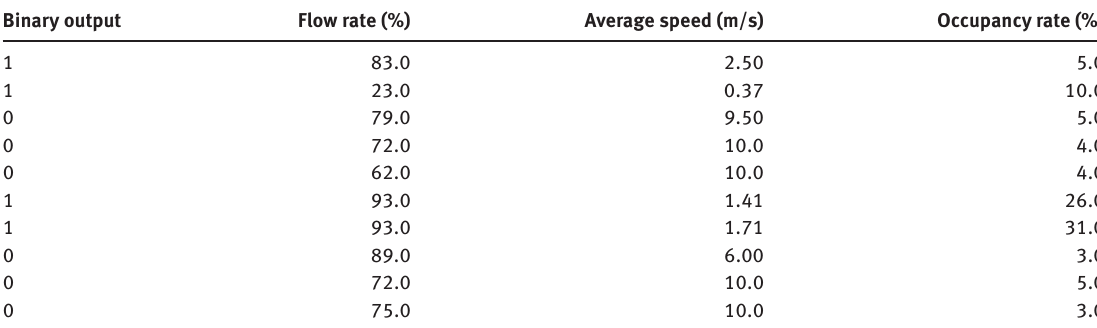
Table 2: Training Data Extracted from Source Domain Network with Three Lanes.